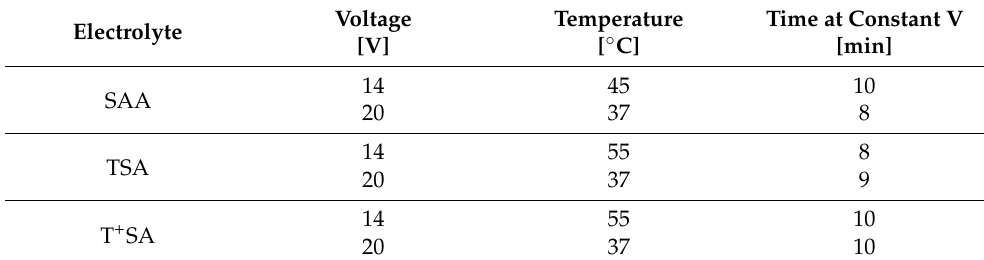
Table 1. Anodising